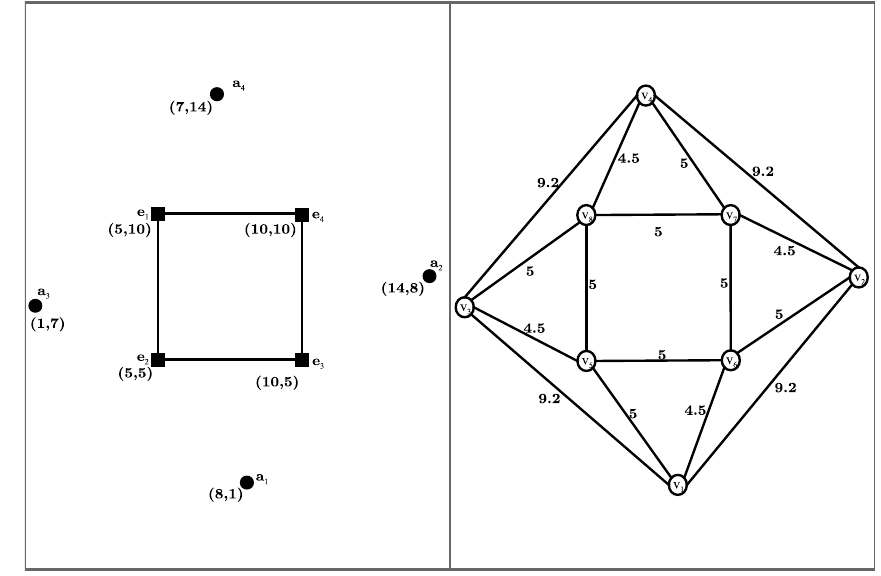
Figure 1. An illustrative example with 4 customers, a single tetragon barrier and the corre- sponding visibility